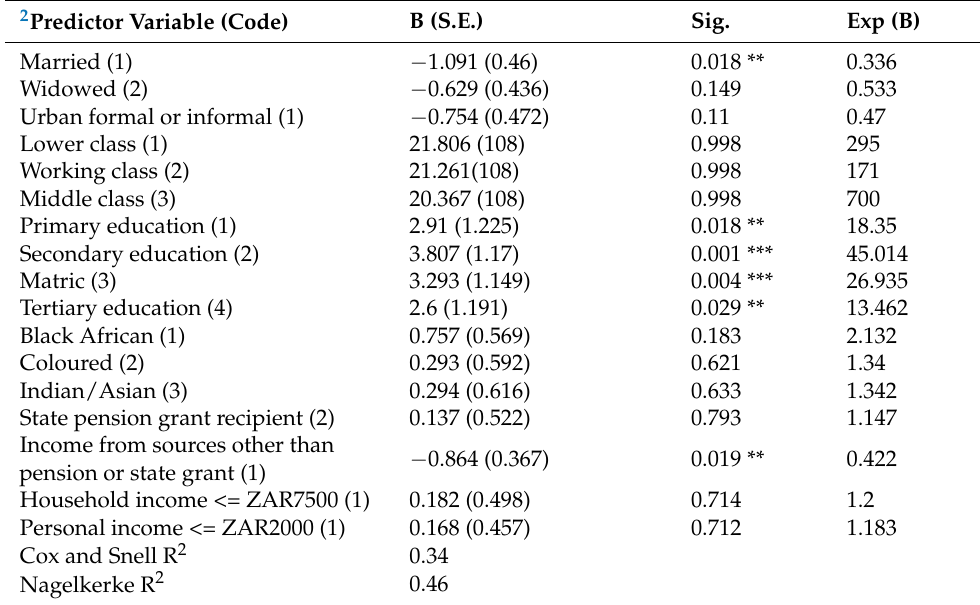
Table 3. A binomial regression analysis on Perceived poverty (Model